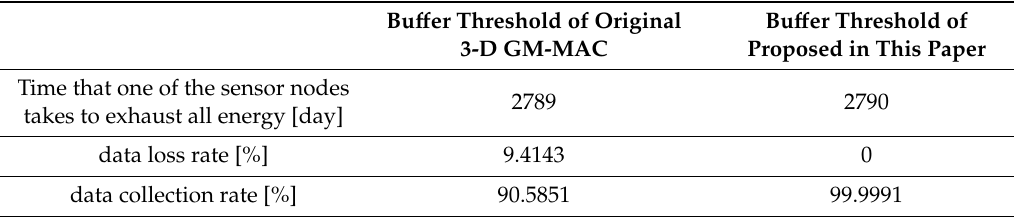
Table 3. Comparison of reconfigurable bu ff er